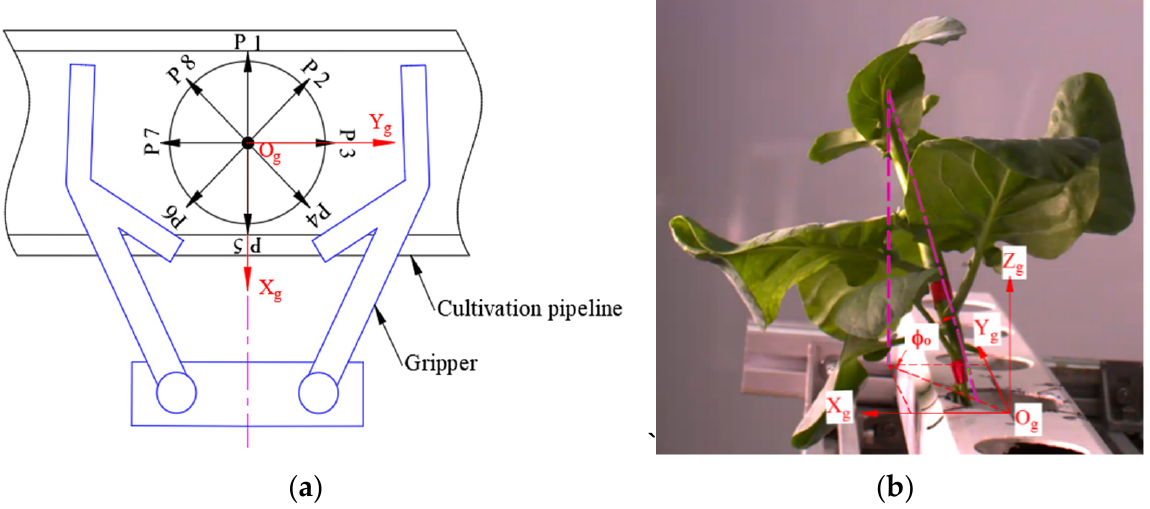
Figure 11. Grasping test platform. 1. Laptop; 2. no.1 high-speed camera; 3. conveyor belt; 4. robotic arm; 5. grabbing mechanism; 6. fill light; 7. hydroponic Chinese kale; 8. cultivation pipeline; 9. brack- ets for cultivation pipeline; 10. no.2 high-speed camera.